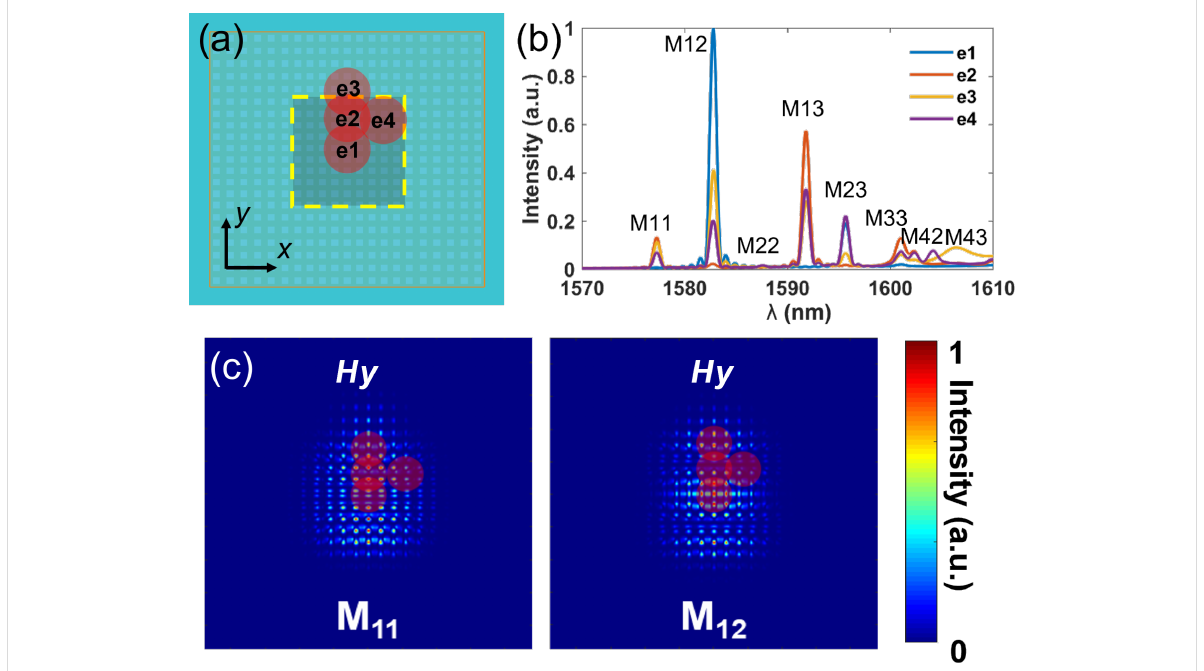
Figure 5: Mode excitation efficiency analysis. (a) Schematic of the illumination positions on the designed cavity. (b) Resonance spectra of the cavity under Gaussian beam excitation with y -polarized H-field positions e1 to e4 shown in (a). (c) The y -polarized H field mode intensity profiles of modes M 11 and M 12